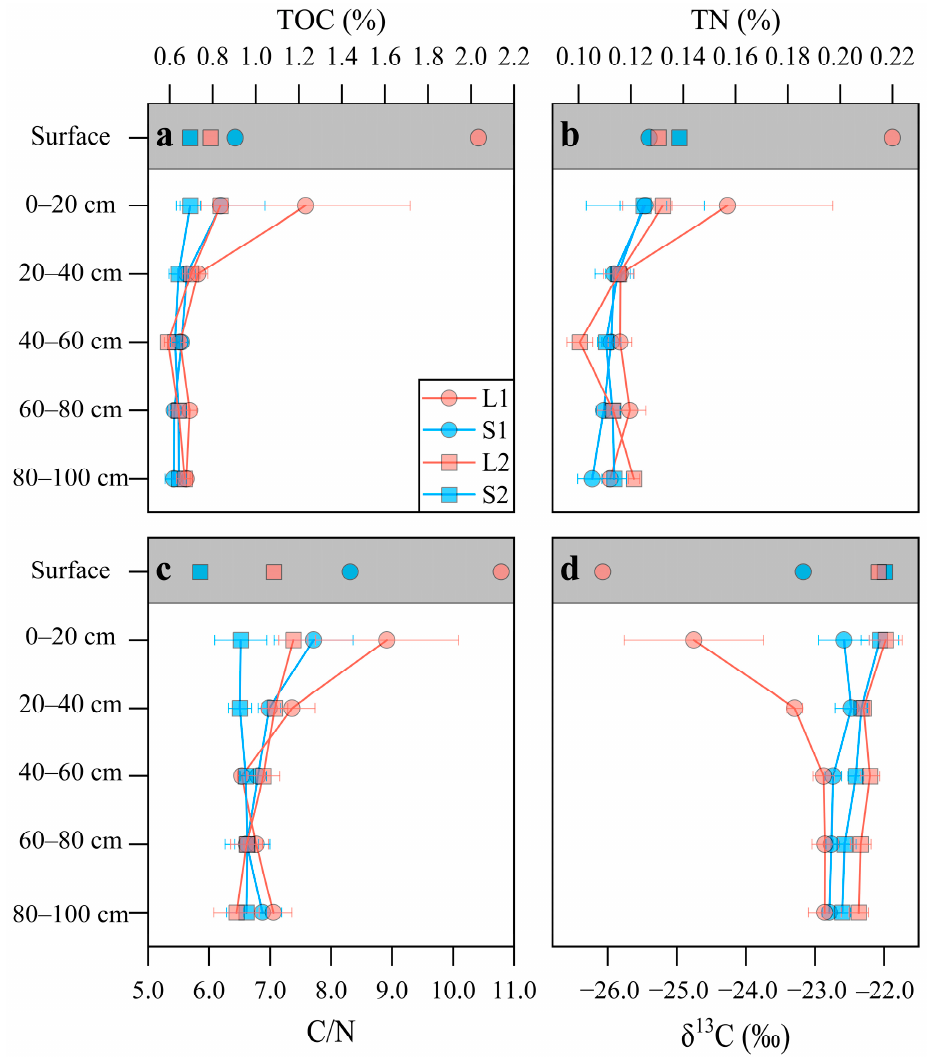
Figure 4. Vertical profile of different parameters ( a ) TOC, ( b ) TN, ( c ) C/N and ( d ) δ 13 C along the sediment cores. Gray area represents surface sediments at depth of 0–2 cm. Each segment data point is presented as mean ± standard deviation. Error bar indicates standard deviation.